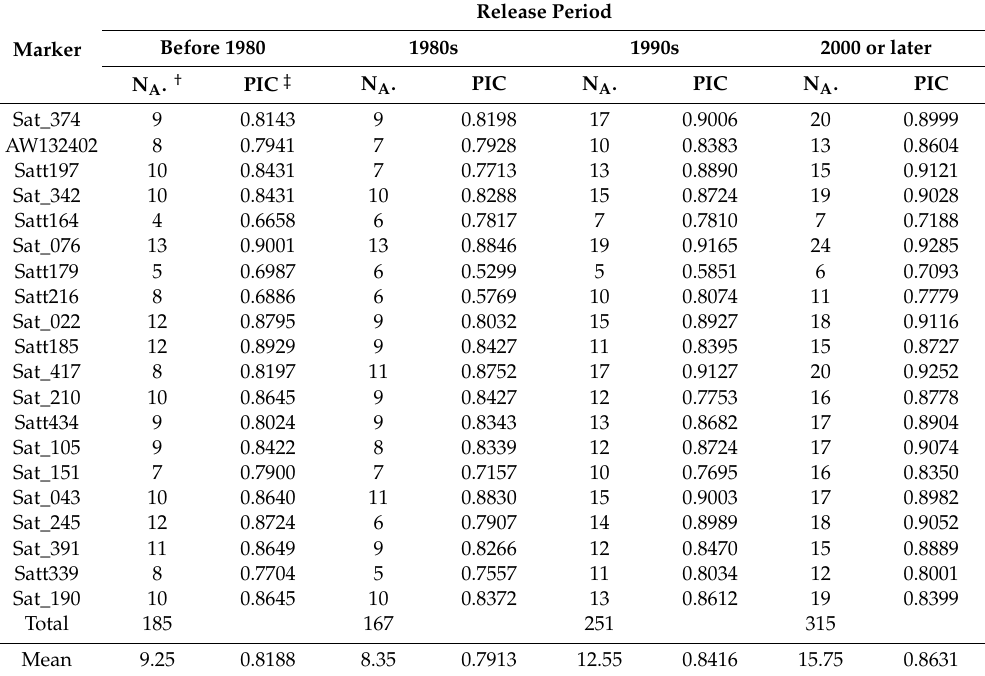
Table 6. Information of 20 markers used for SSR analysis by release period.